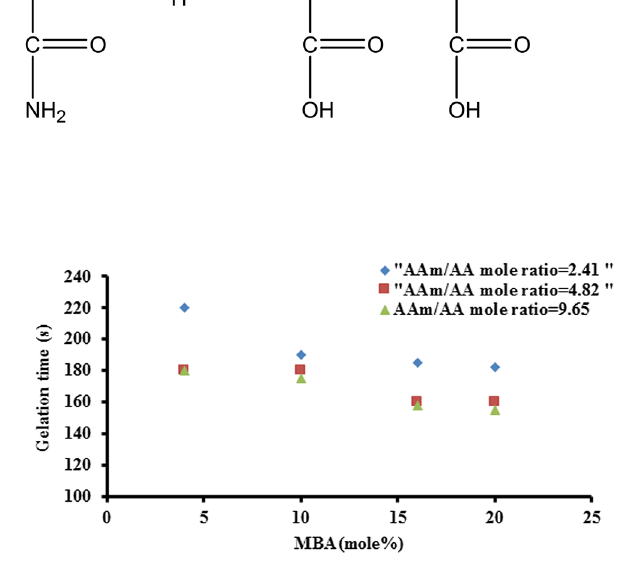
Fig. 2 Effect of MBA mole percentage on the gelation